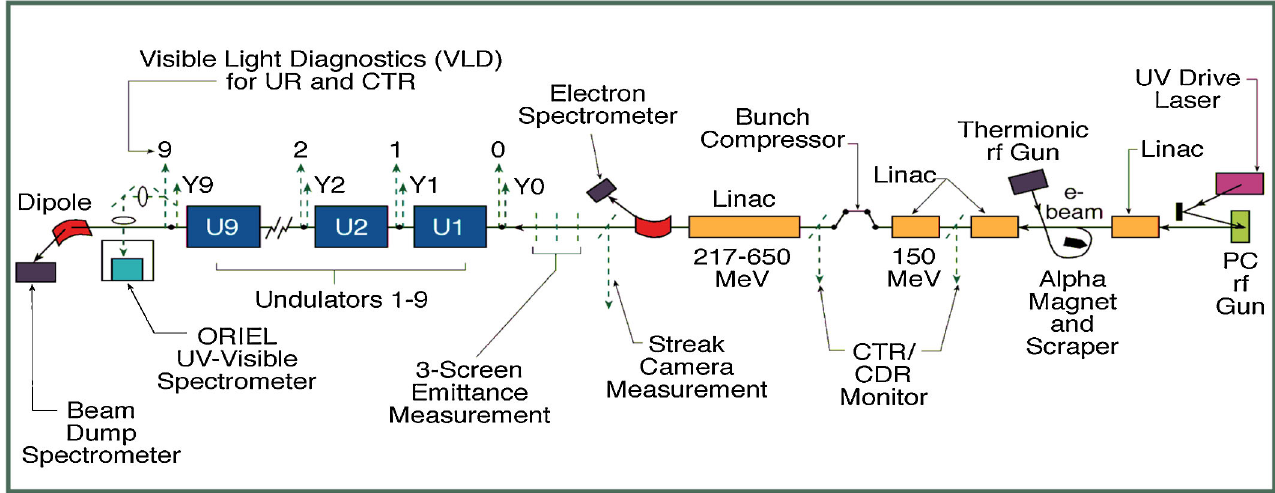
FIG. 2. (Color) A schematic of the APS linac test area showing the PC rf gun, the TC rf gun, the accelerator structures, the chicane, the decommissioned FEL with VLD stations after each of nine undulators, the imaging optical spectrometer, and the electron beam dump circa 2001 (Ref.